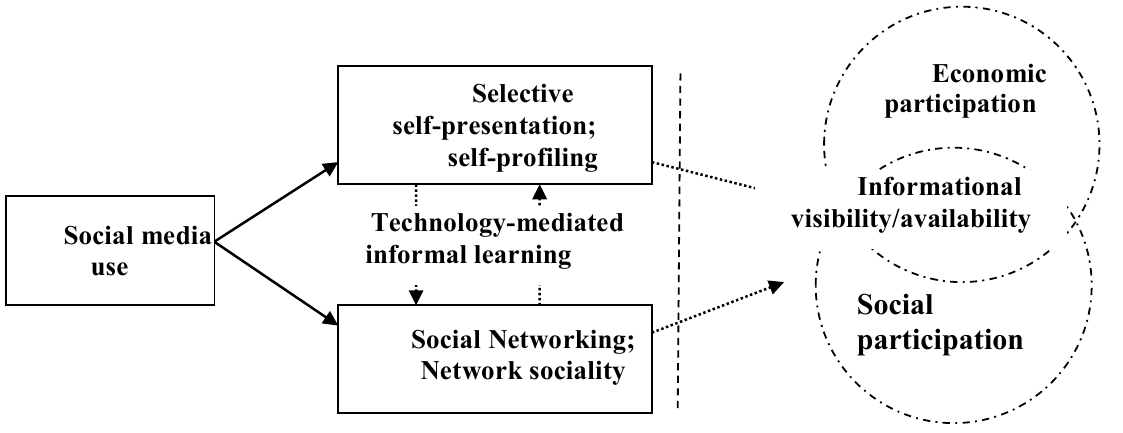
Figure 1. Technology-mediated informal